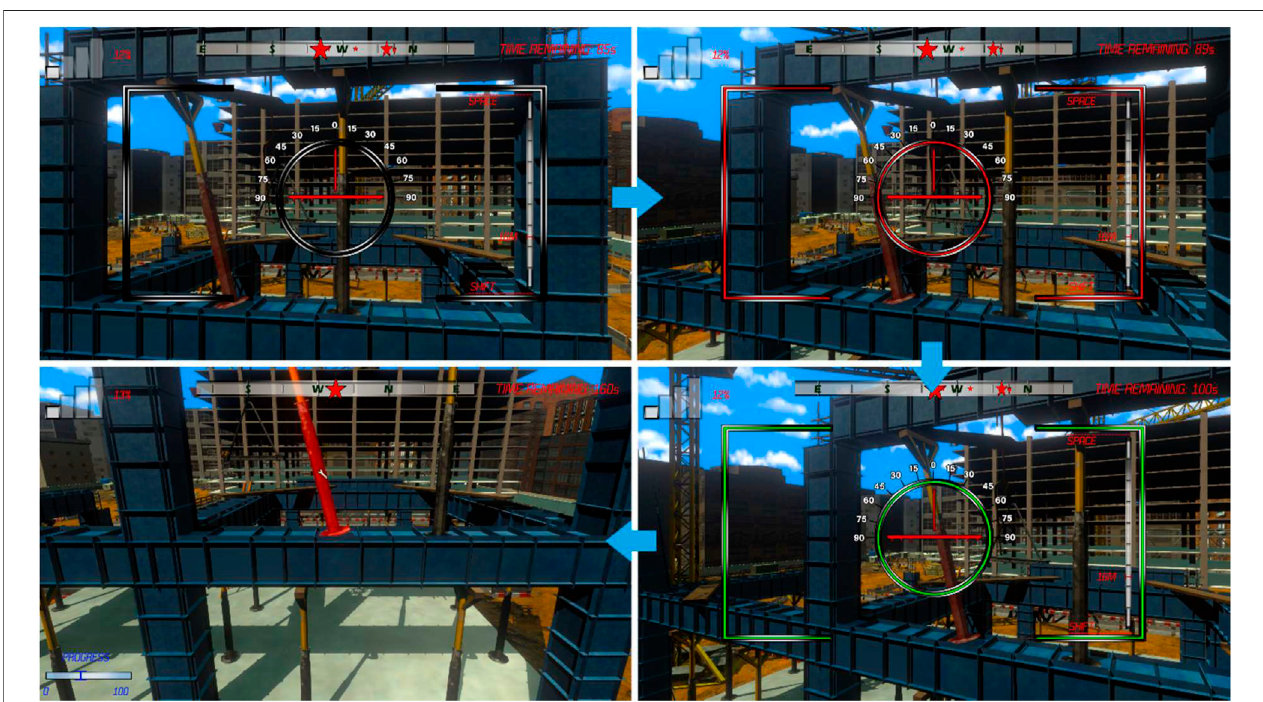
FIGURE 3 | Screenshots showing the different states the view fi nder can be in when trying to locate hazards using the on-board camera of the drone.